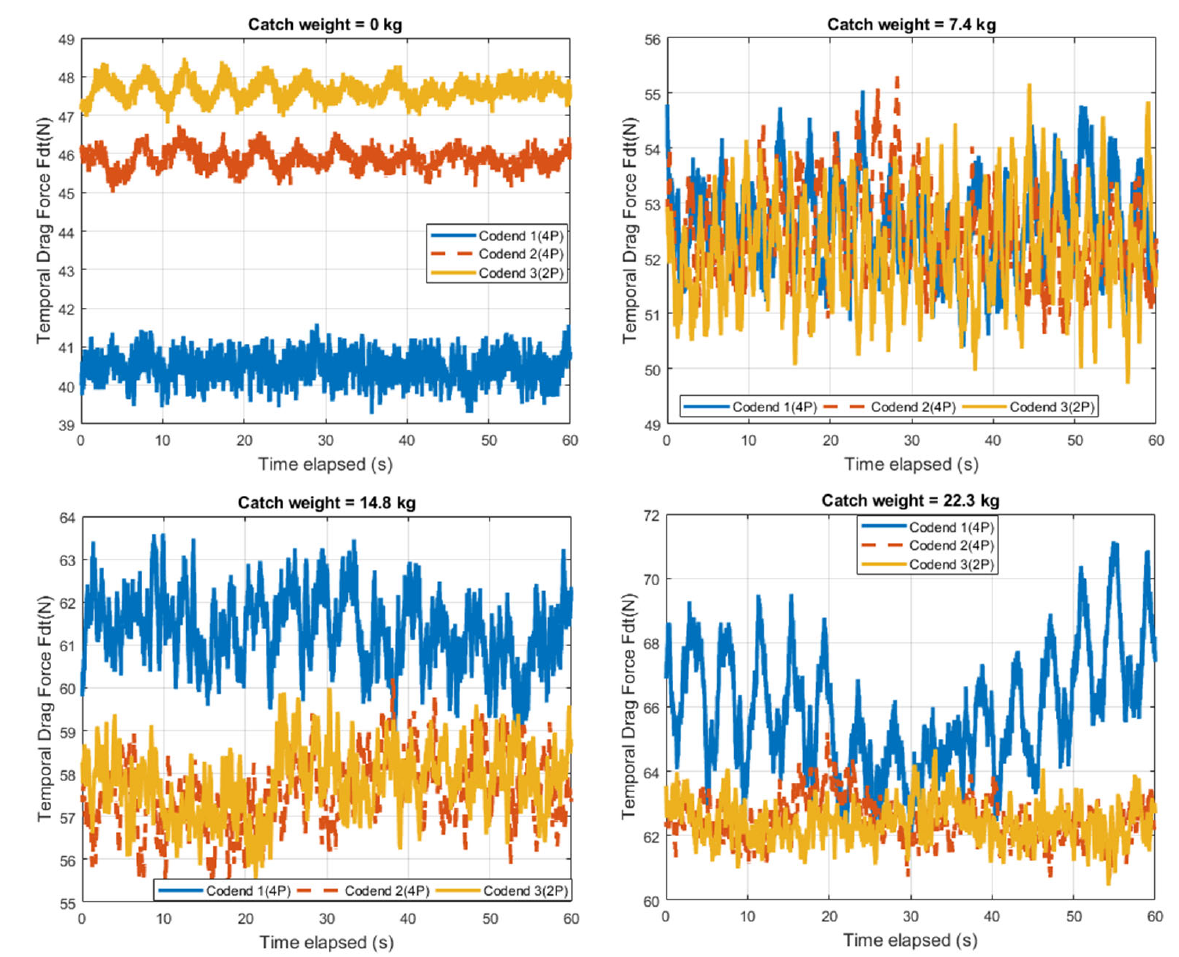
Figure 5. Time evolution of the three codend drag forces at different catch weight and at 𝑢 (cid:2868) = 0.9 m/s.